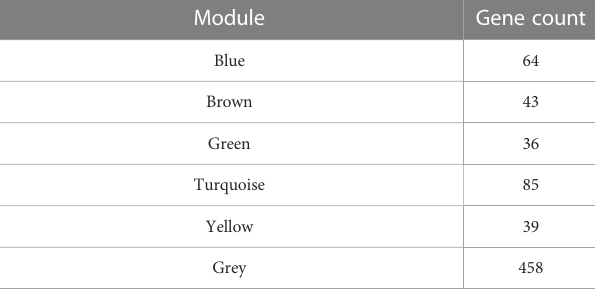
TABLE 2 The number of genes in the coexpression